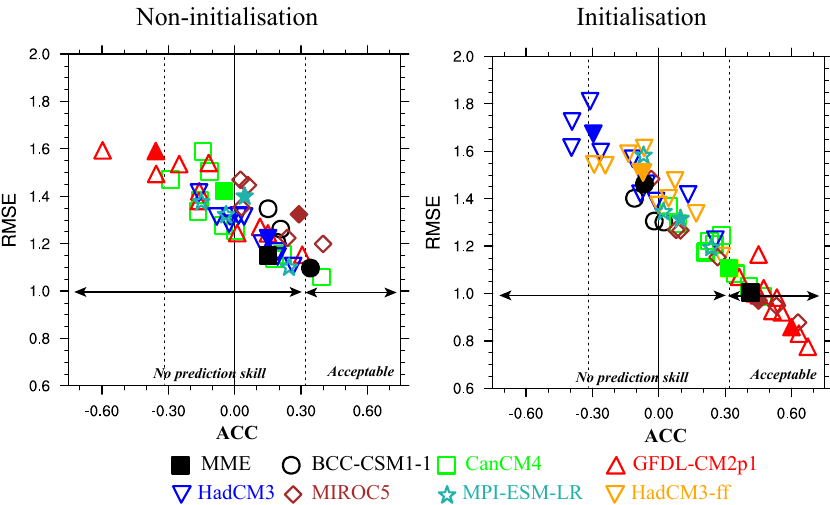
Figure 3. Performance of the model ensemble member (open marker) and its ensemble mean (solid marker) on the EASM index. The abscissa and ordinates are the anomaly correlation coefficient (ACC) and the root mean square error (RMSE), respectively. The observation of the EASM index is calculated by zonal wind at 850hPa from the ERA-Interim reanalysis data. The black dotted lines indicate the significance level at 0.1. The vertical black line represents the correlation between the simulation and the observation of the EASM index at 0.